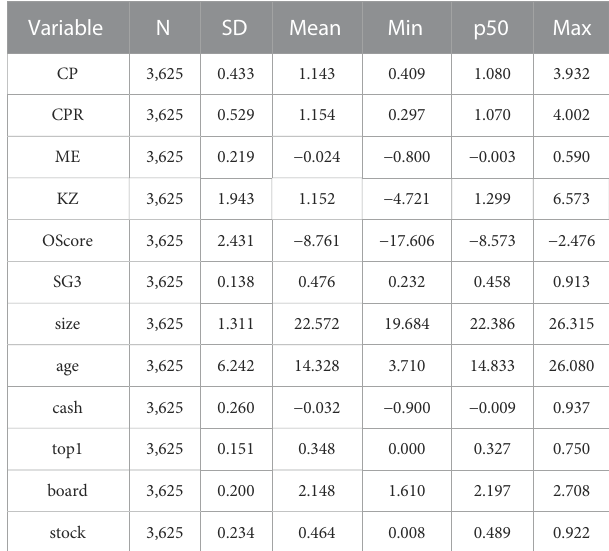
TABLE 2 Descriptive